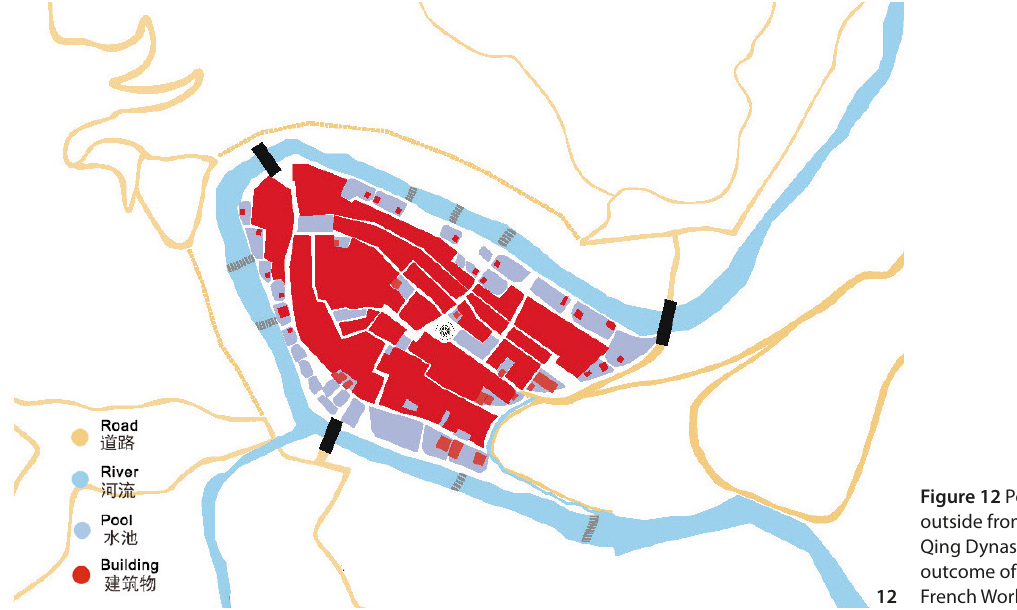
Figure 12 Ponds located in the outside from the Ming and the Qing Dynasty to 1949 (Source: outcome of Zengchong Chinese- French